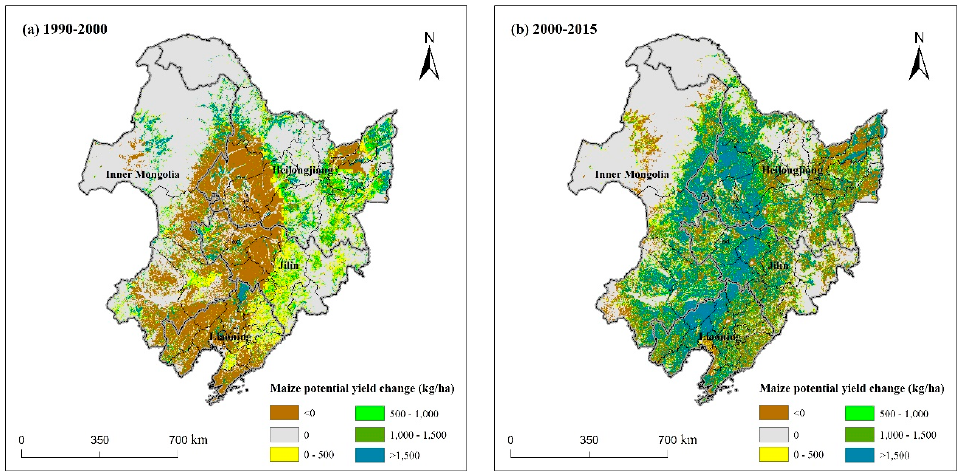
Figure 7. Maize potential yield changes from 1990 to 2015 in Northeast China. ( a ) 1990–2000; (b) 2000–2015. Maize potential subtypes also changed dramatically from 1990 to 2015 (Figure 8). There were two kinds of maize subtypes, early maturing maize and late maturing maize, simulated by the GAEZ model in years 1990, 2000, and 2015 (Figure 8). The length of growth period (LGP) is closely related to temperature sums of more than 10 °C (Tsum 10 ). In Northeast China, early maturing maize grows well in the regions where the Tsum 10 is 1700–2300 °C, and the LGP is about 110 days. Late maturing maize with the LGP of more than 120 days grows well in the regions where the Tsum 10 is 2300–3200